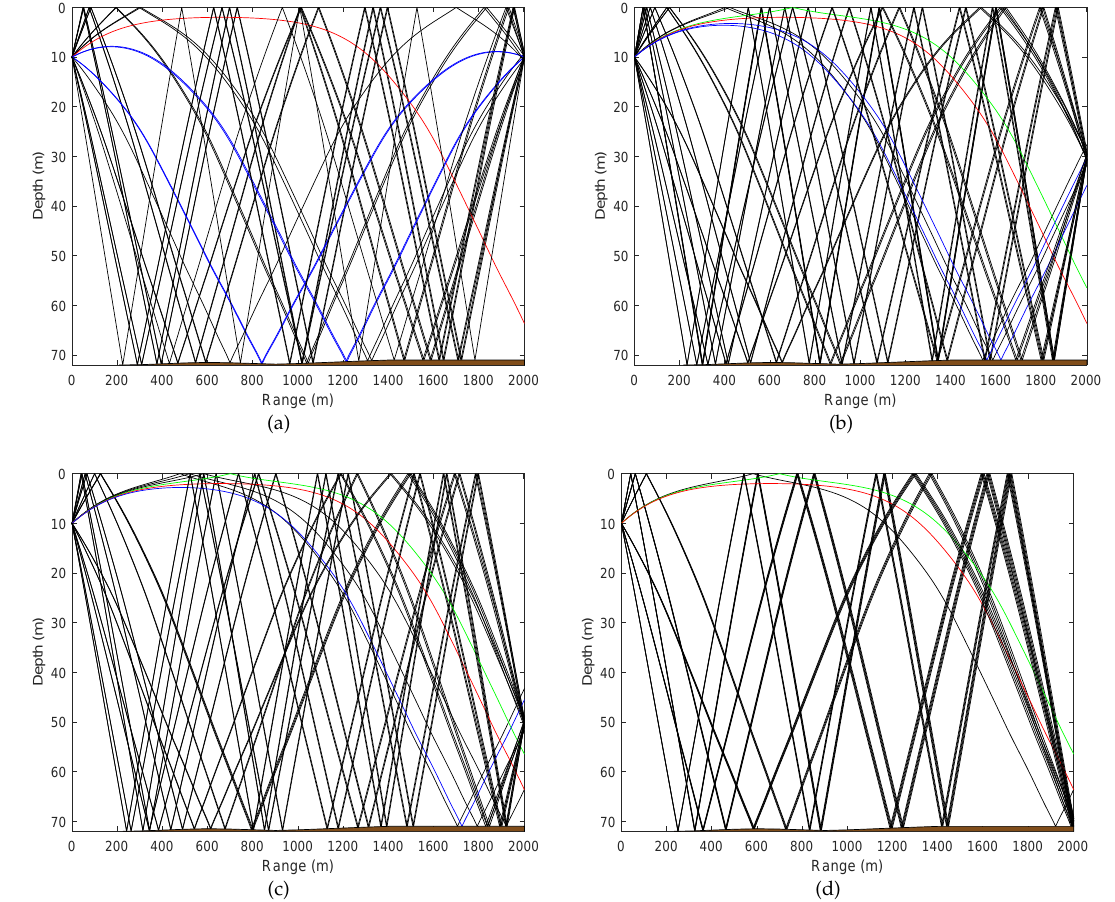
Figure 6. Eigenrays of channel with different receiving depth. The color of lines indicates whether eigenrays hit surface boundary or bottom boundary of the sea. Receiving depth of each figure: ( a ) 10 m; ( b ) 30 m; ( c ) 50 m; ( d ) 70 m. Different types and lengths of eigenrays lead to different transmission losses and time